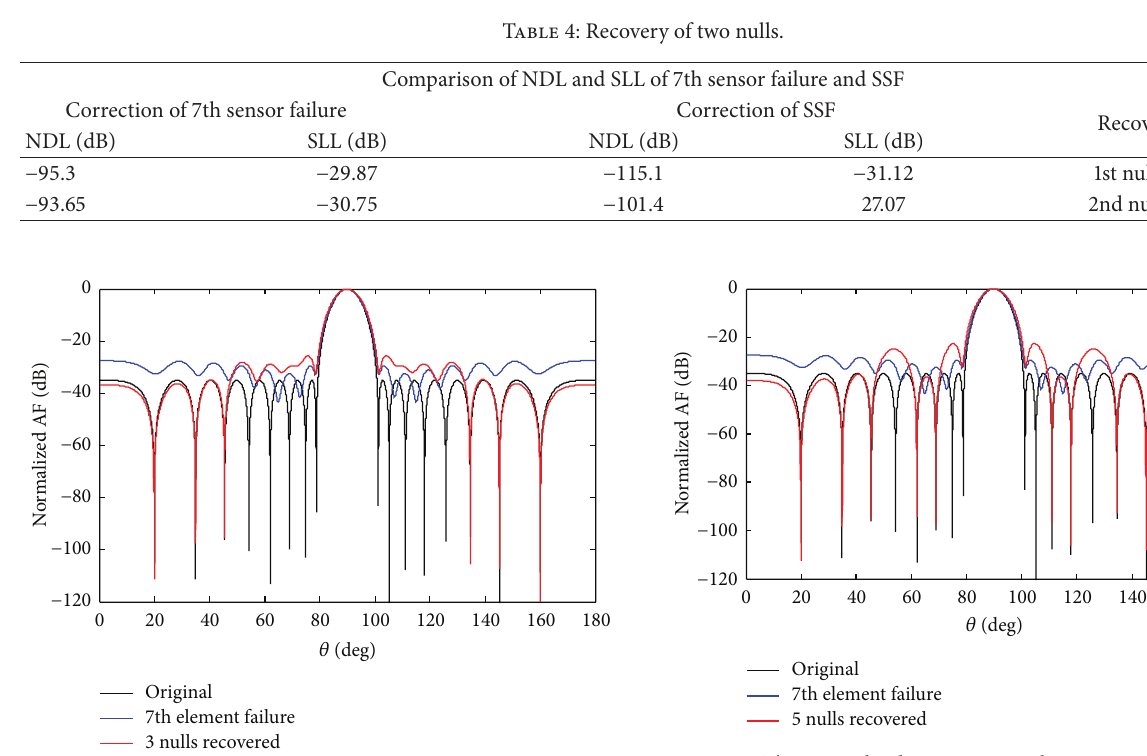
Figure10:Theoriginalradiationpattern,the 𝑤 7 sensordamage,and recovery of five